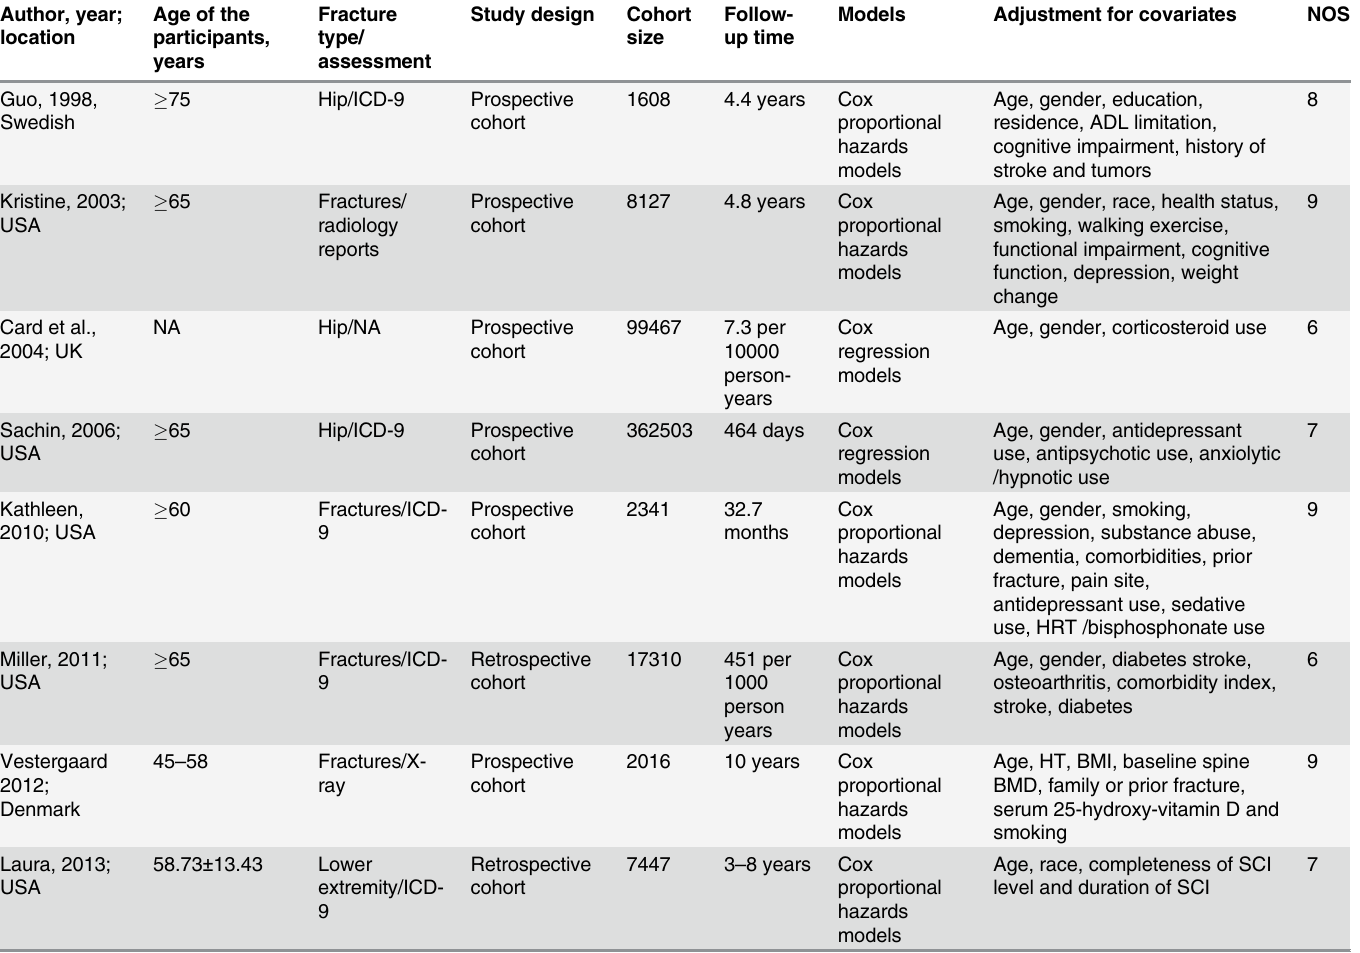
Table 1. Characteristics of the 8 Cohort Studies included in the Final Analysis of Opioids and Fracture